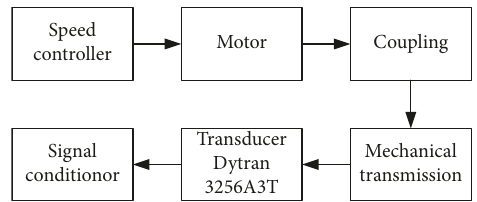
Figure 3: The schematic illustration of the mechanical trans- mission experimental